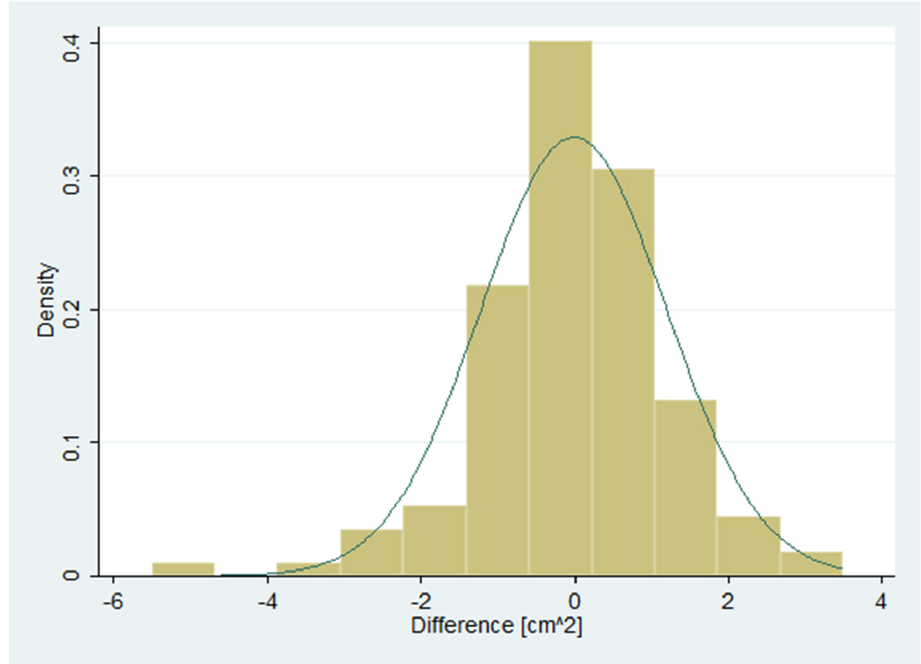
Figure 2. Histogram with approximating normal distribution of interrater differences (n = 140).